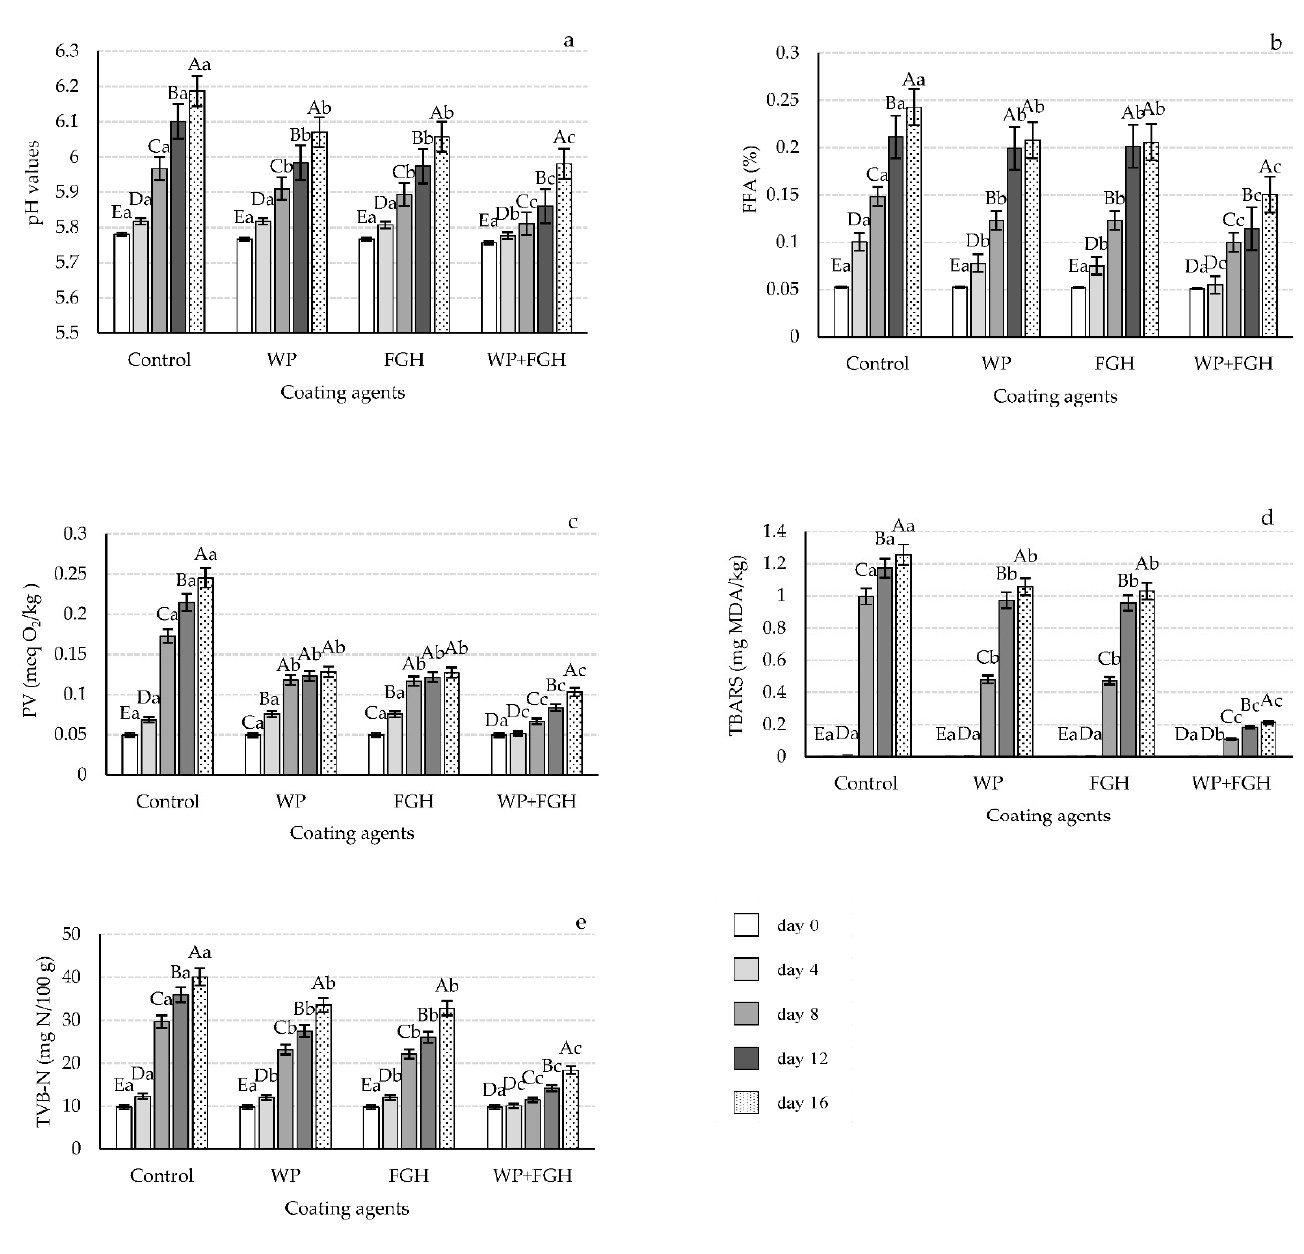
Figure 2. Changes in ( a ) pH value, ( b ) free fatty acid (FFA) contents, ( c ) peroxide value (PV), ( d ) thiobarbituric acid reactive substances (TBARS), and ( e ) total volatile basic nitrogen (TVB-N) of chicken breast fillets coated with whey protein (WP), fish gelatin hydrolysates (FGH), and a combination of both (WP + FGH) during cold storage at 4 °C. Data are represented as mean ± standard deviation ( n = 3). Different uppercase letters represent statistically significant differences ( p < 0.05) between various days of storage within samples receiving the same coating treatment; different lowercase letters indicate statistically significant differences ( p < 0.05) of samples receiving the different coating treatments within the same storage time.